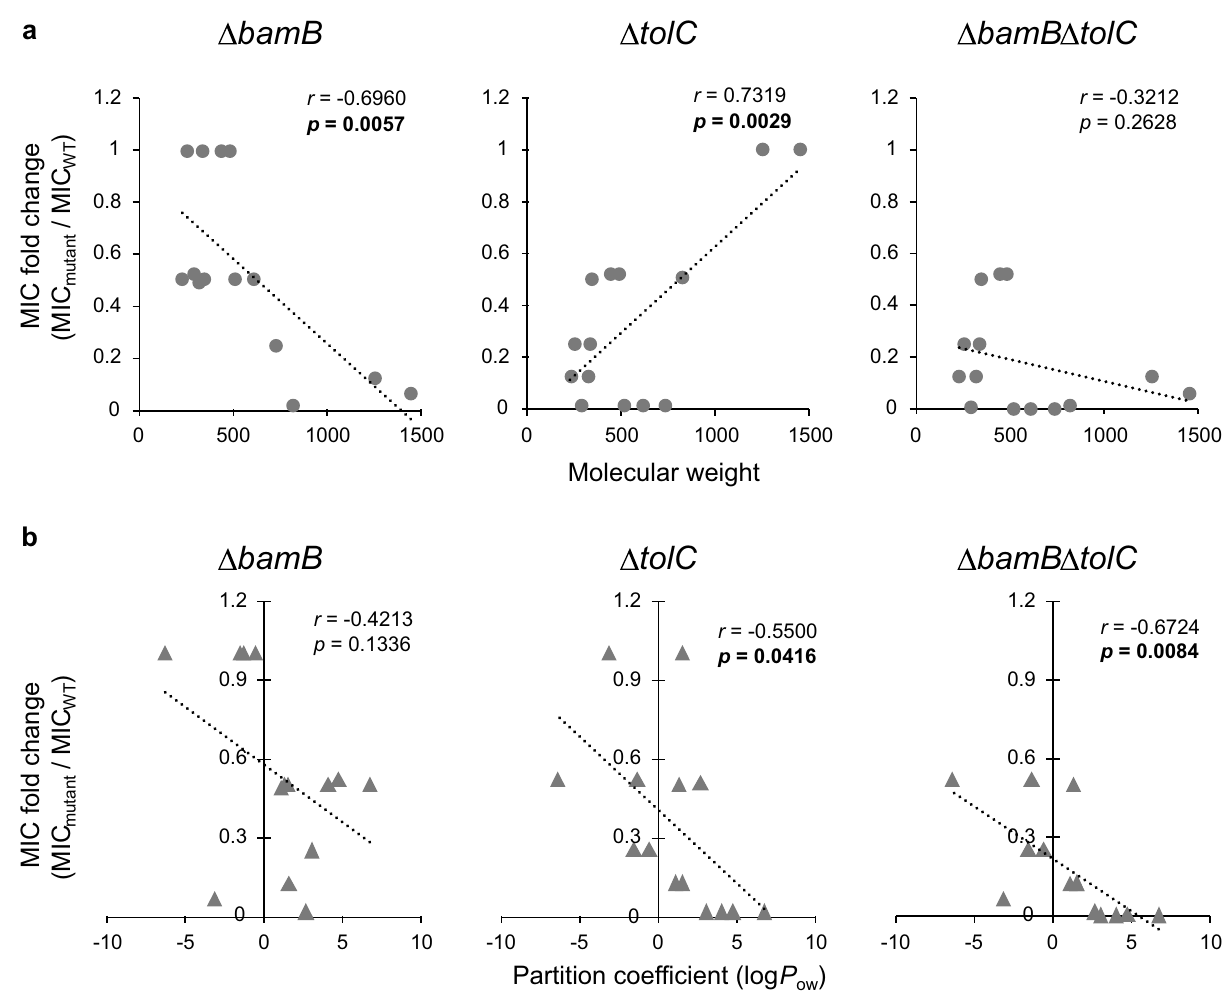
Figure 2. Correlation between MIC fold change and scaffold size or hydrophobicity. The MIC fold change (each mutant/the wild type strain) and ( a ) scaffold size or ( b ) hydrophobicity of antimicrobial compounds are plotted for each mutant. The dotted line represents a regression line. The correlation coefficient ( r ) and p value by Pearson’s correlation analysis are indicated within each panel; p value in bold means significant at p =